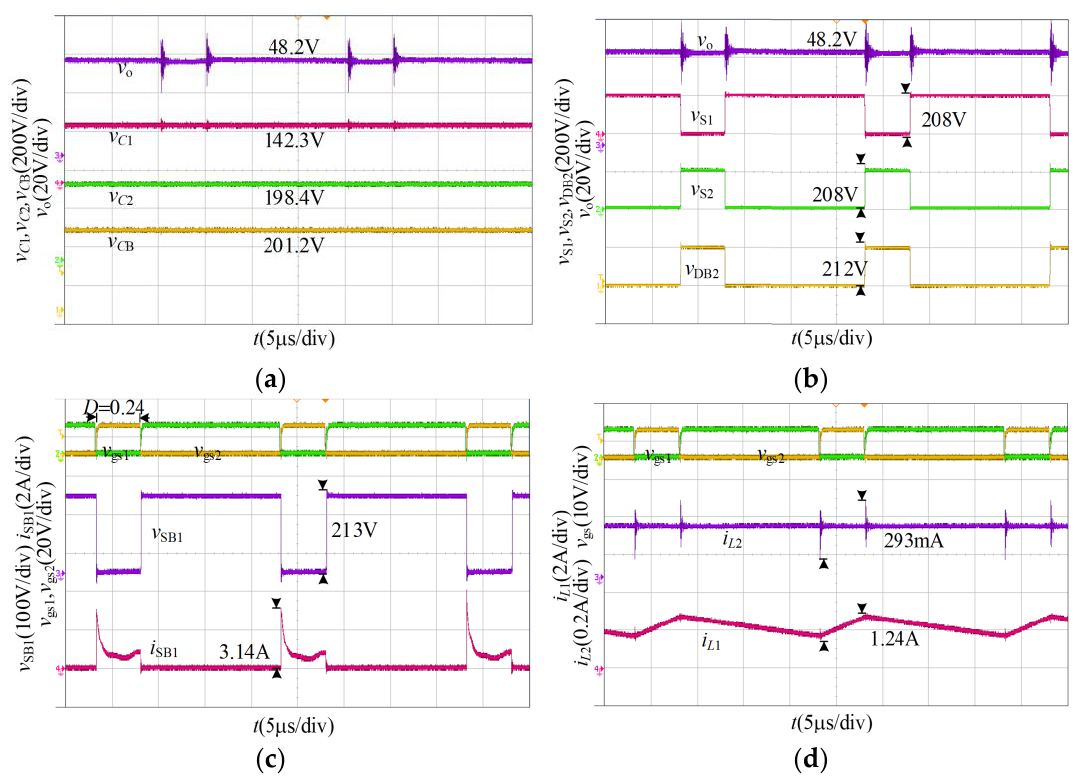
Figure 16. The steady waveforms of the proposed converter in step-down mode: ( a ) v o , v C1 , v C2 , v CB ; ( b ) v o , v S1 , v S2 , v DB2 ; ( c ) v gs1 , v gs2 , v SB1 , i SB1 ; ( d ) v gs1 , v gs2 , i L1 , i L2 .